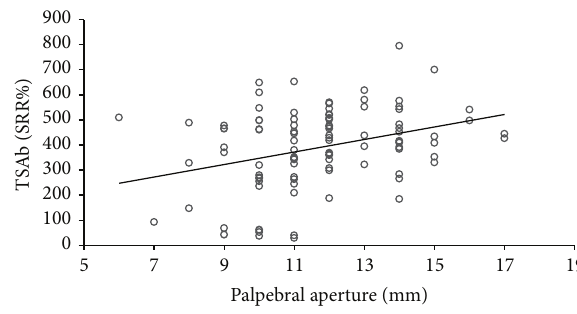
Figure 2: Correlation of serum TSAb levels with palpebral aperture. Spearman’s rho = 0.29; 𝑃 = 0.003 .